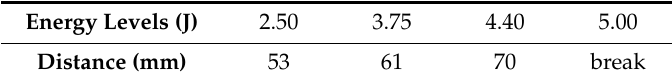
Table 5. Distance travelled by the matrix cracking on the bottom surface of the EP-BF10 sample at di ff erent impact energy levels.